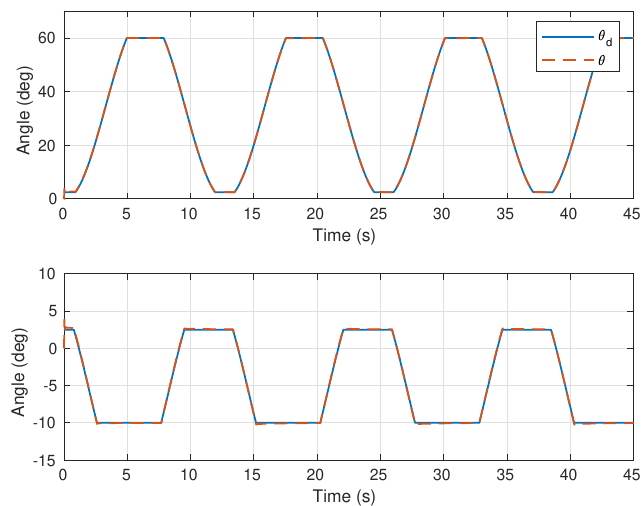
Figure 14. Simulation results on trajectory tracking on manipulator with bidirectional rotations. (3) PAMs in antagonistic pairs control simulation with uncertainty and disturbance.